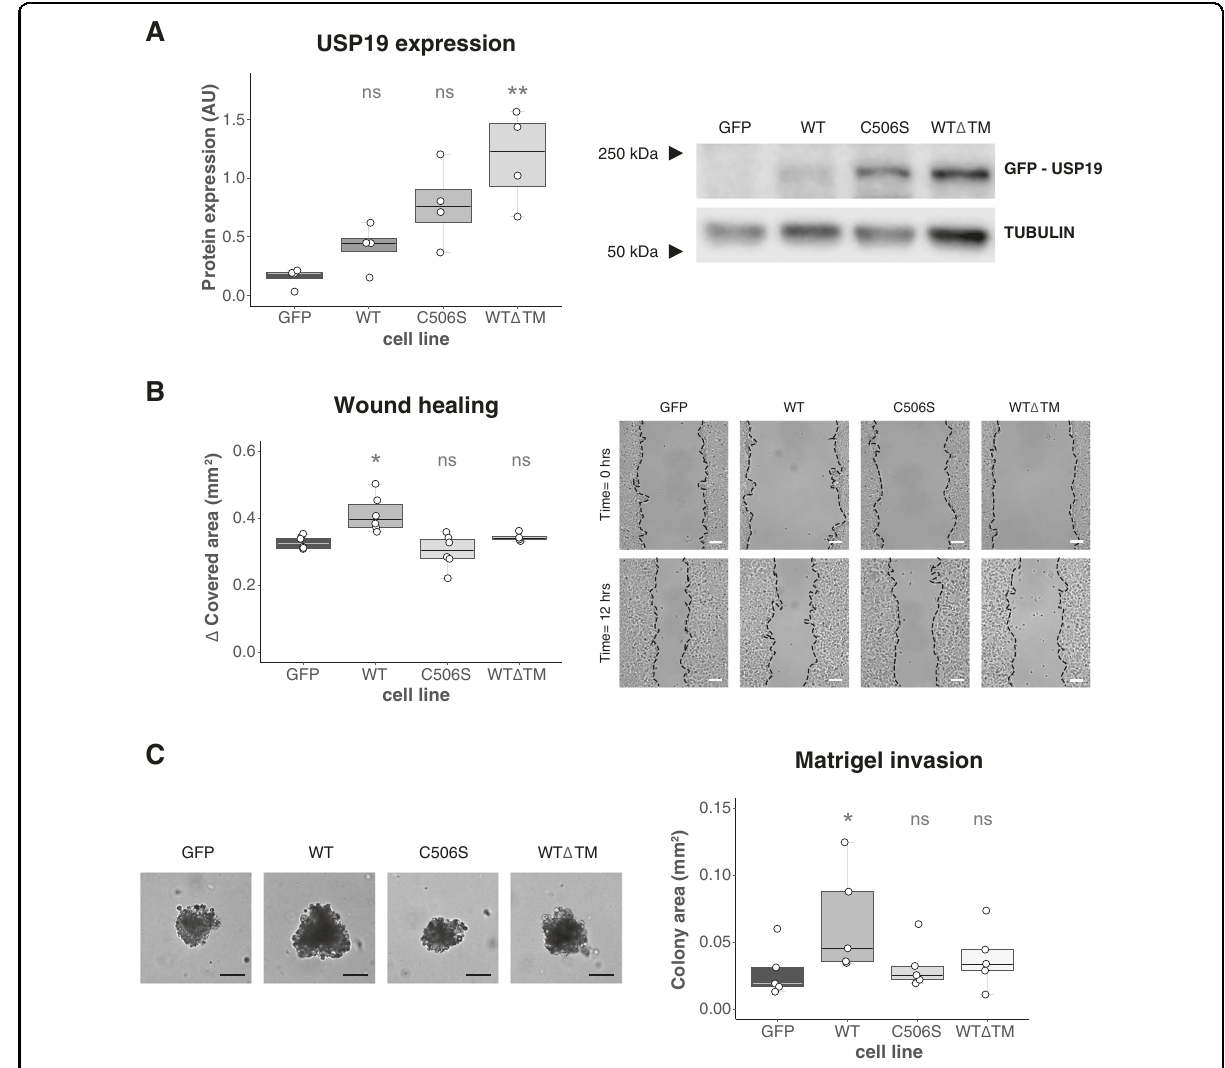
Fig. 4 USP19 wild-type overexpression enhances migration and invasion in MCF7 cells. A Different constructs of USP19 were overexpressed in MCF7 cells, and their expression con fi rmed by Western Blotting ( n = 4, Kruskal – Wallis, Dunn ’ s multiple comparison test. WT p > 0.9999, C506S p = 0.0777, and WT Δ TM p = 0.0070). B The migratory potential was evaluated by wound-healing assay. Left: gap covered area (mm 2 ) after 12 h ( n ≥ 4, Kruskal – Wallis, Dunn ’ s multiple comparison test. WT p = 0.0107, C506S p > 0.9999, WT Δ TM p > 0.9999) and right: representative areas in a wound- healing experiment at the indicated time points. Scale bar = 100 μ m. C Matrigel invasion was assessed over a 30 days period. Left: Representative bright fi eld images obtained at the end of the experiment using a ×10 objective are shown; scale bar = 100 μ m. Right: colony size was calculated ( n ≥ 4, Kruskal – Wallis, Dunn ’ s multiple comparison test. WT p = 0.0485, C506S p > 0.9999, WT Δ TM p >